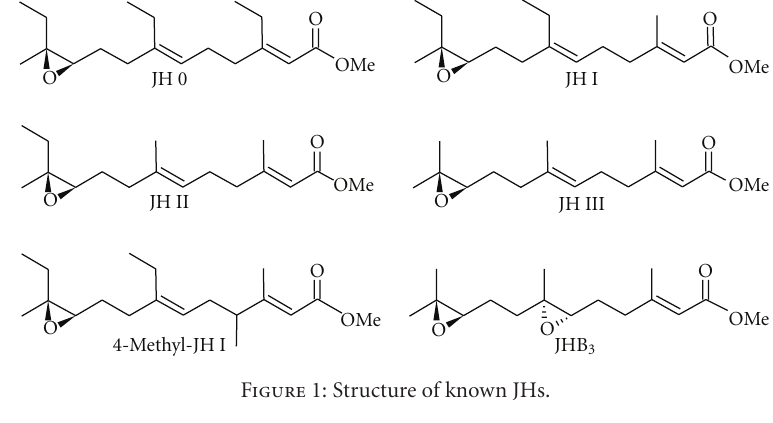
Figure 1: Structure of known JHs.